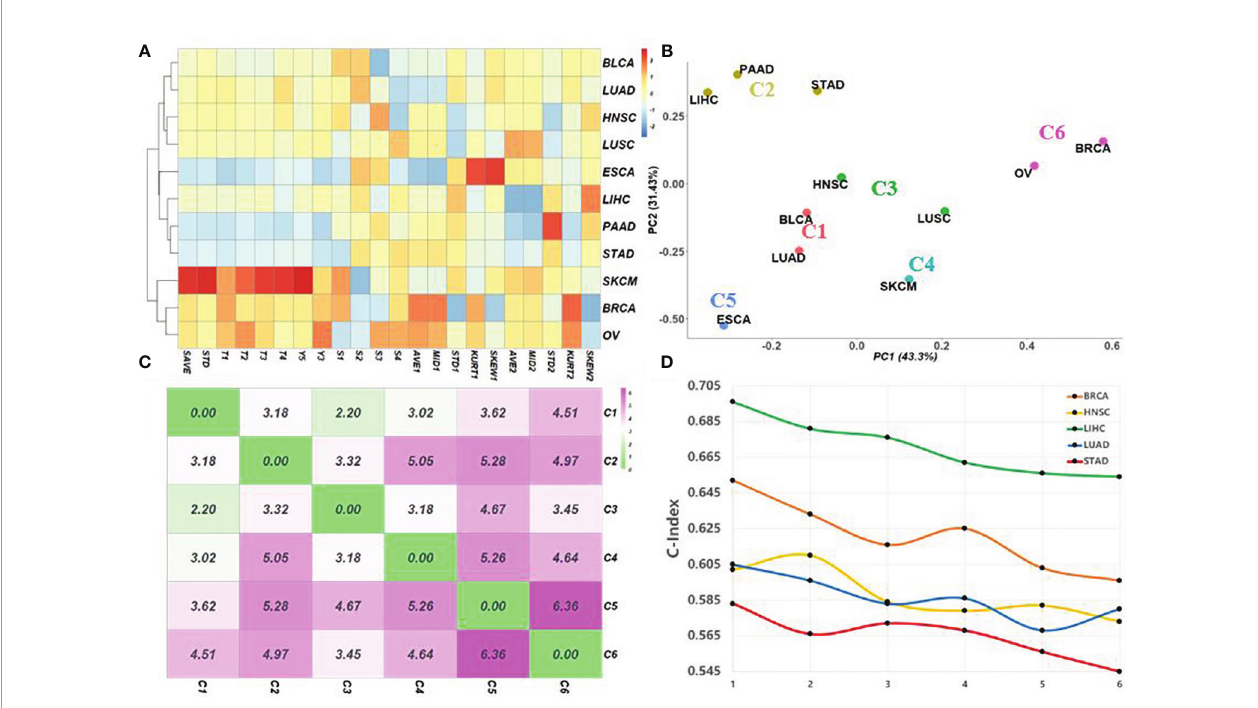
FIGURE 2 | Survival characteristics for matching appropriate pre-training cancer data adaptively. (A) Normalized cancer description matrix of 11 different cancers in The Cancer Genome Atlas (TCGA) by using 12 phenotype and 10 genotype characteristics. (B) Corresponding clustering results obtained by k -means ( k = 6). (C) Distances between the centers of the different clusters. (D) C-index values obtained using different pre-training data combinations based on cluster distances. The points on the x -axis represent the combination of pre-training data arranged according to distance from near to